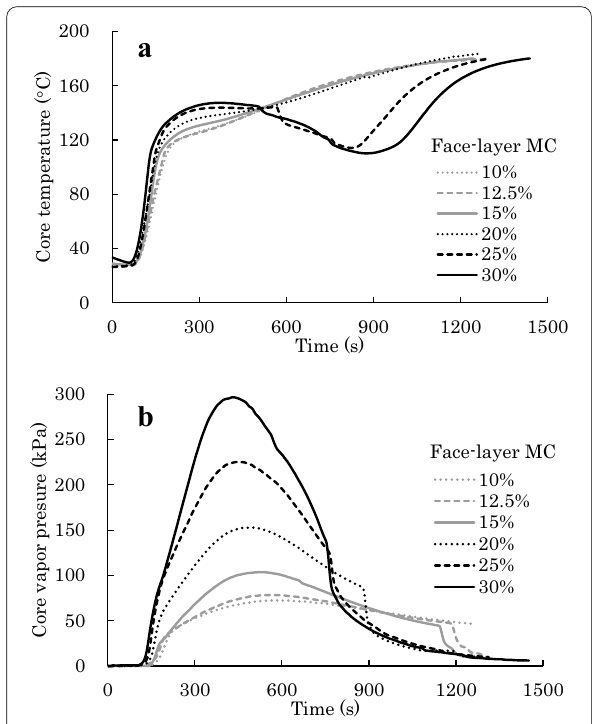
Fig. 2 Typical core a temperature–time and b vapor pressure–time curves in the face-layer MC mat